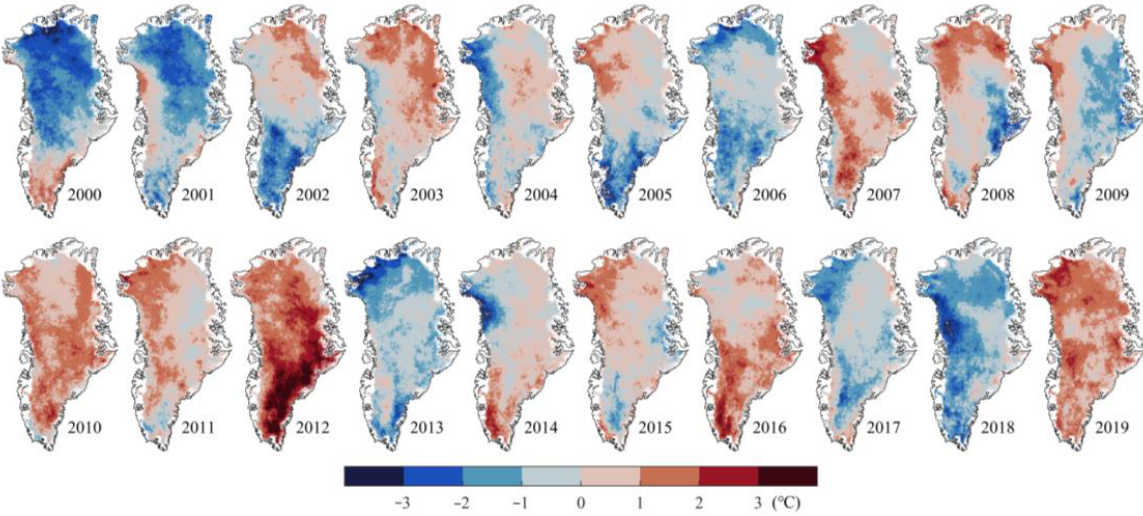
Figure 7. Summer IST anomalies (°C) calculated from monthly IST (2000 to 2019).